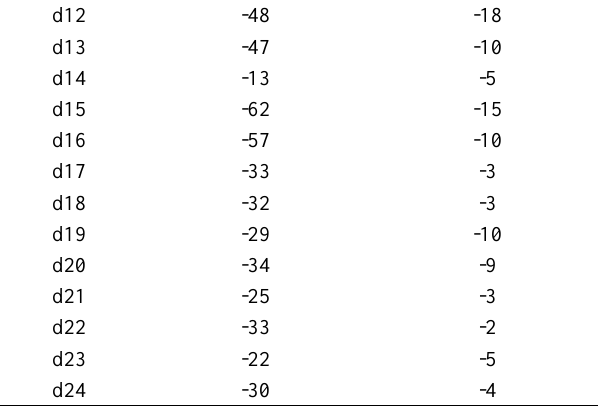
Figure 6. Deformation time series at four typical points (P1-P4), which are located in Figure